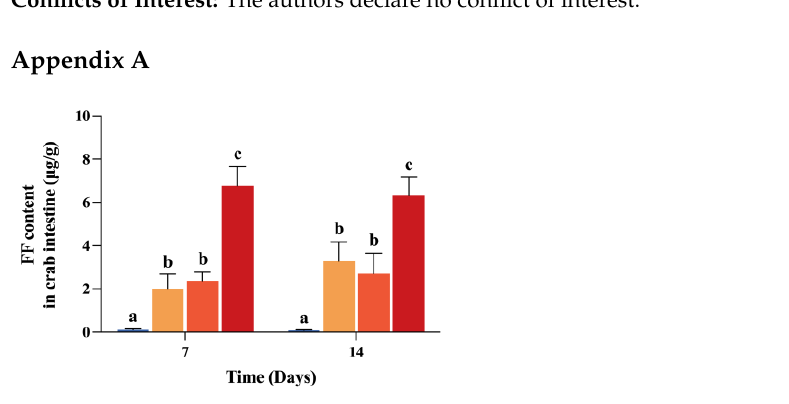
Figure A1. FF content in intestine. Different letters (a, b, c) indicate significant difference among control and three FF exposed groups ( p < 0.05).